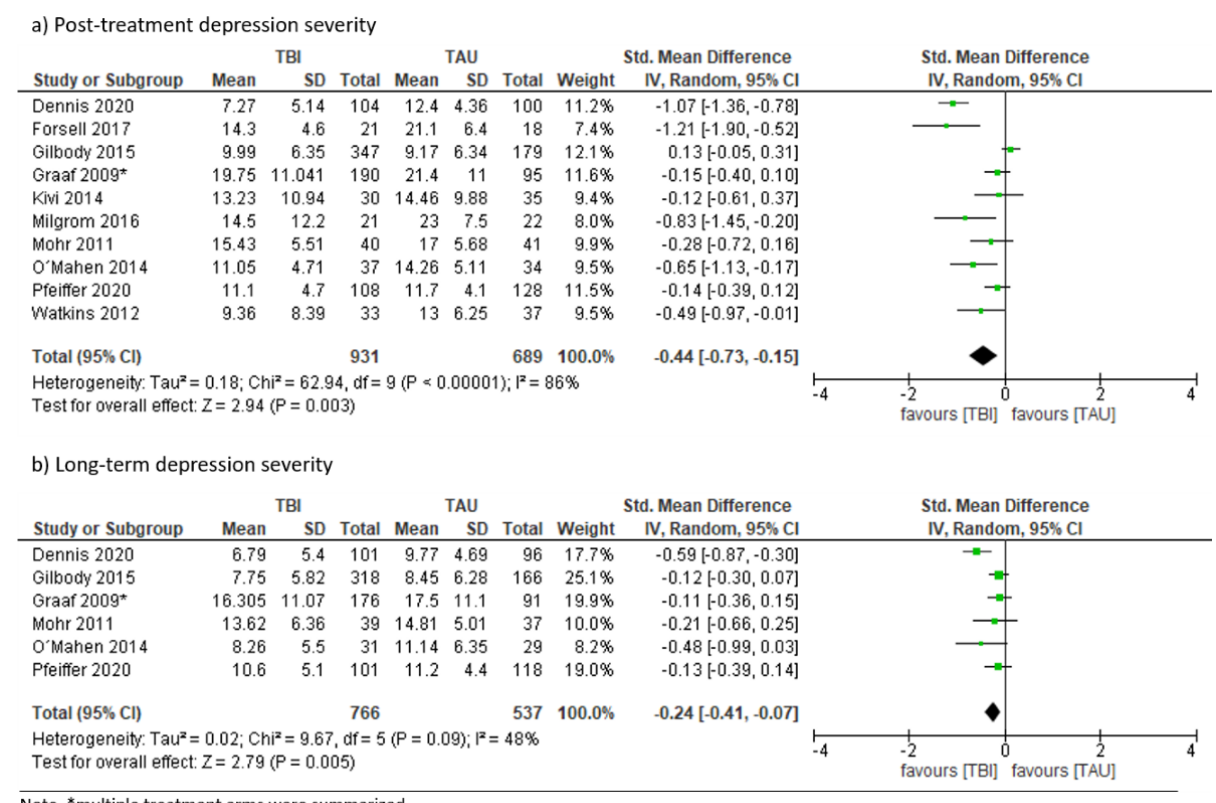
Figure 5. Forest plots on technology-based psychological intervention versus treatment as